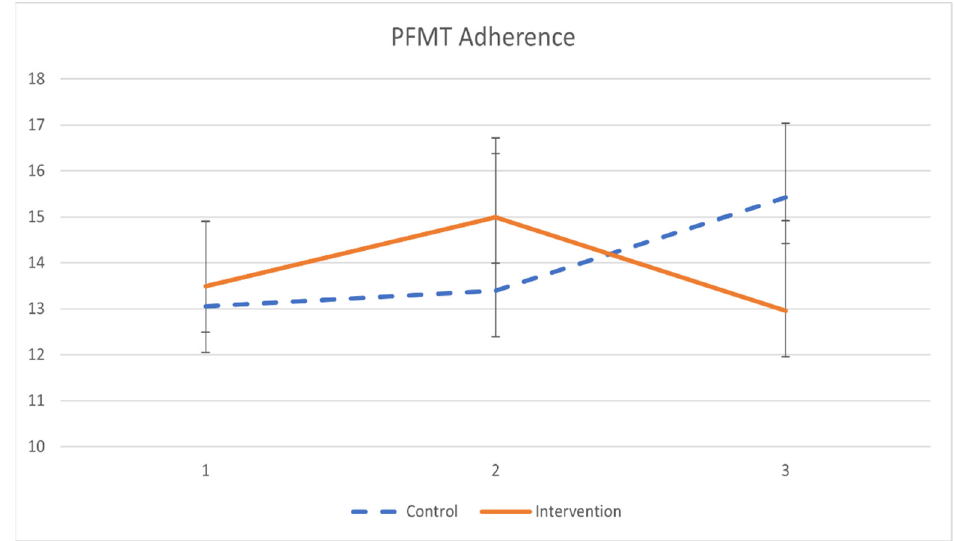
Figure 2. The mean values and standard errors for PFMT adherence of the two groups across the study. Table 6. The effect of KEPT app on PFMT knowledge, attitude, practice, and